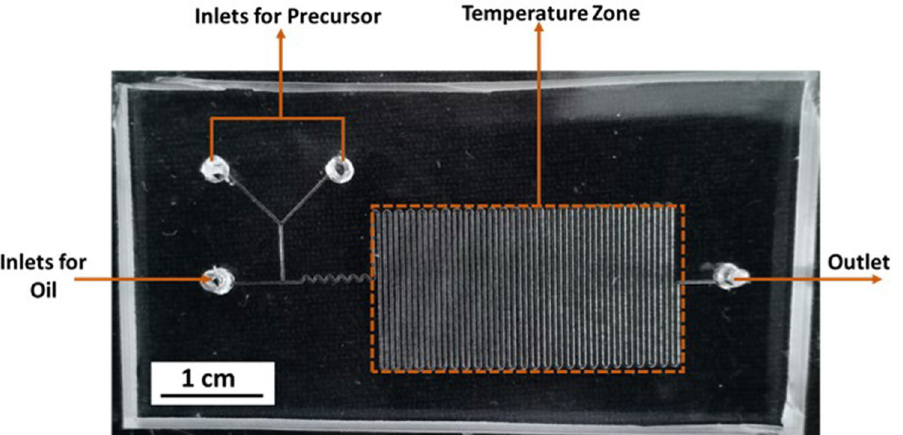
Figure 3. PDMS based droplet microfluidic channel bonded on to a glass substrate. The channel has a uniform width of 175 µm and a depth of 35 µm throughout. The length and breadth of temperature zone is 2.5 × 1.5